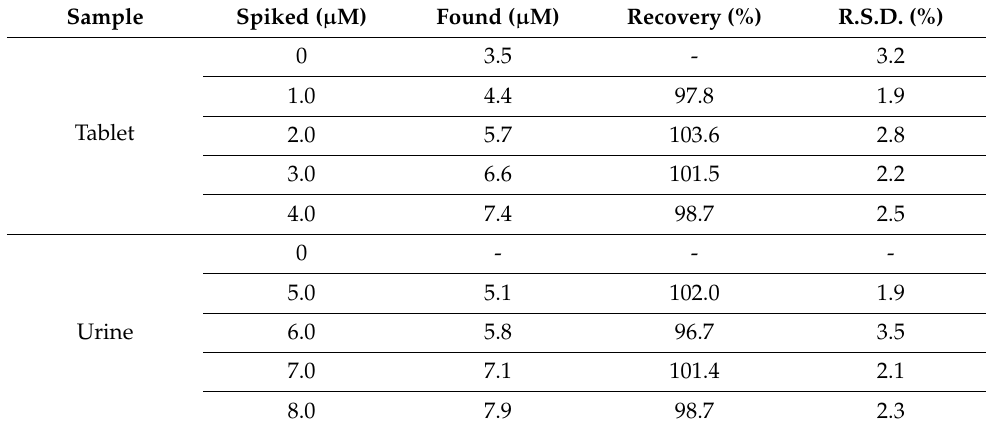
Table 2. Voltammetric sensing of KTC in real specimens using Ce-BTC MOF/IL/CPE (n = 5). Sample Spiked ( µ M) Found ( µ M) Recovery (%) R.S.D. (%)